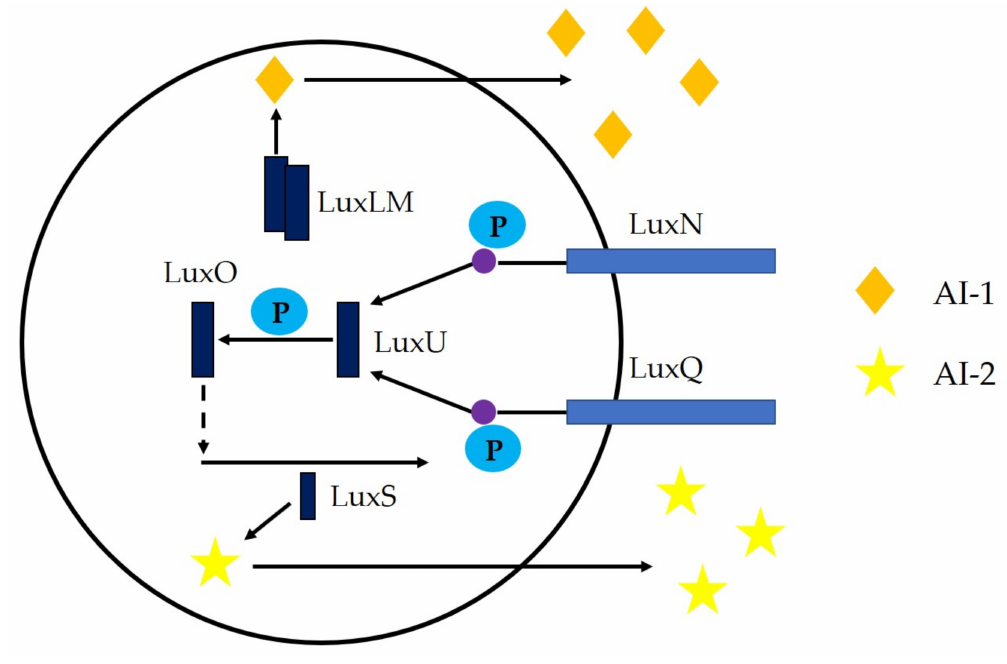
Figure 4. AI-2 quorum-sensing